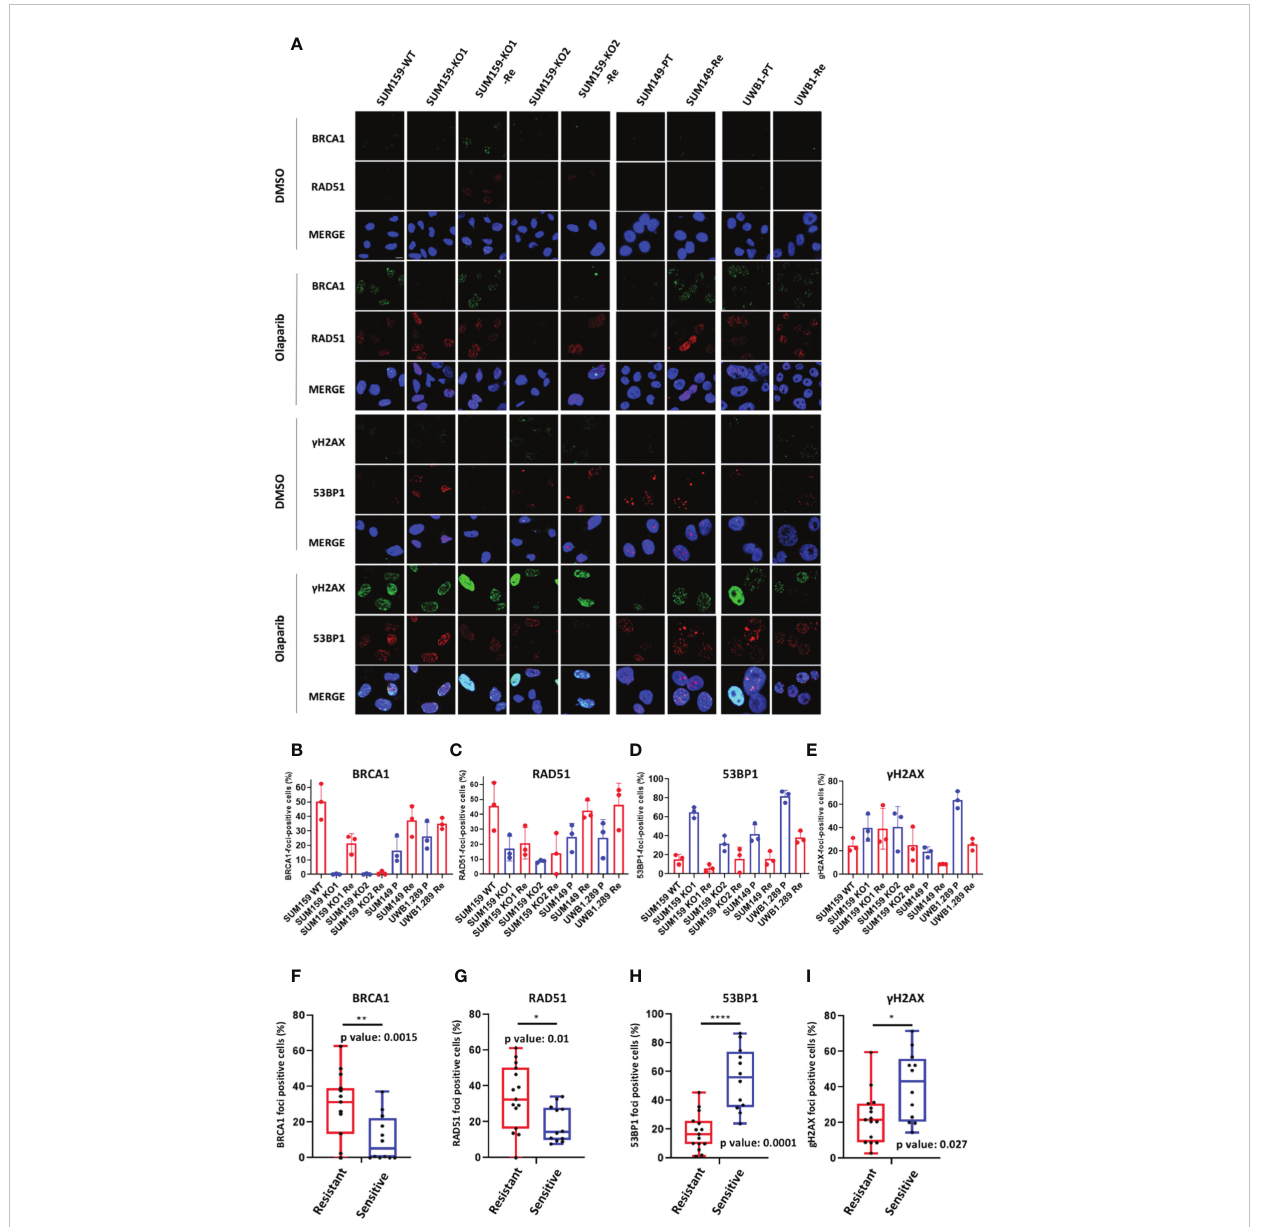
FIGURE 5 BRCA1, RAD51, g H2AX and 53BP1 nuclear foci in BRCA1 de fi cient cell line models (A) Representative immuno fl uorescence images of cell line models treated or not (control) with Olaparib for 24h. Cell line names are indicated on top BRCA1 -WT (WT), BRCA1-KO (KO), BRCA1-KO-Ola-Resistant